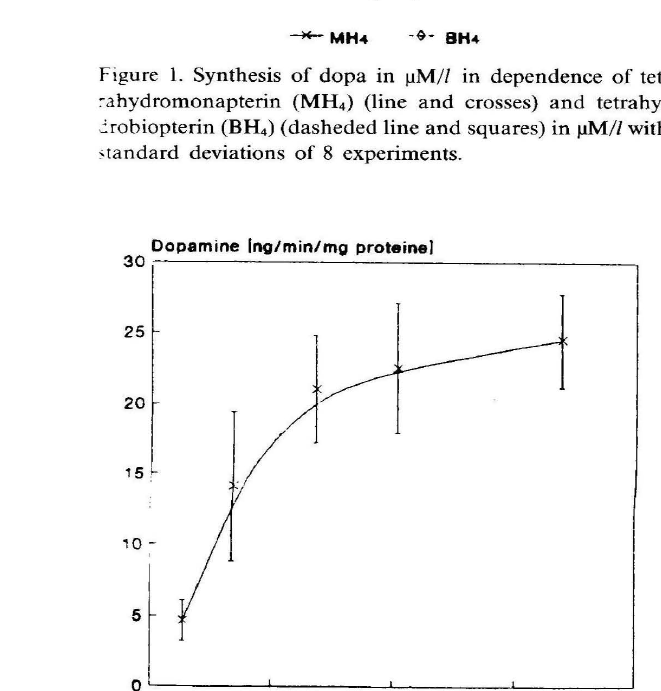
Figure 2. Dopamine synthesis in nglmin/(mg bovine retina protein) in dependence of dopa in JlM/Z with standard de- viation of 7